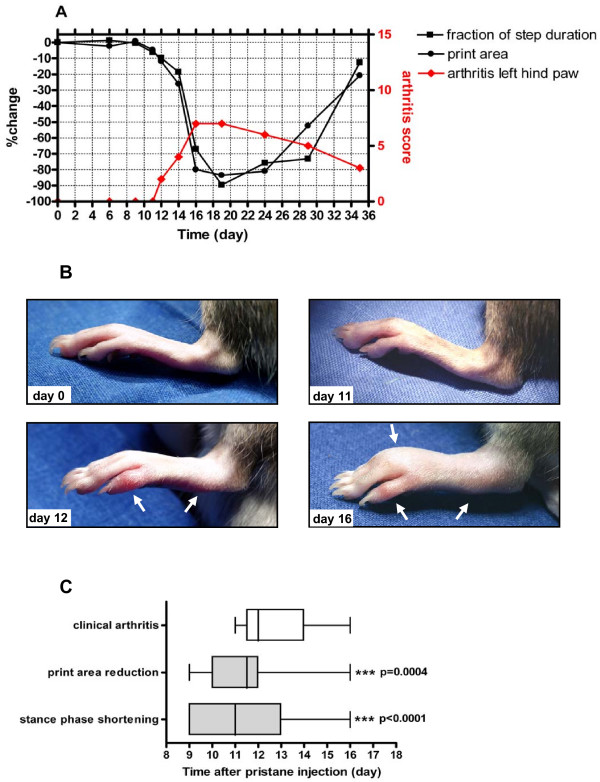
Gait changes occur before visible arthritis is apparent. (A) Time course of the print area and the duration of stance phase measured as the fraction of total step duration of a representative left hind paw after pristane-injection. (B) Photographic images of the left hind paw at characteristic time points (before pristane injection = Day 0, clinically unaffected joint showing gait changes = Day 11, onset of clinical PIA = Day 12, full-blown acute PIA = Day 16). Arrows show location of erythema and swelling on Day 12 and Day 16. (C) Comparison of day of onset of significant gait changes (defined by >5% reduction of print area or shortening of stance phase time versus pre-operative values) versus clinically apparent arthritis in paws with severe arthritis (arthritis score ≥5) reveals that print area reduction and stance phase shortening occur significantly before onset of apparent PIA. Data are presented as box plots. Lines within the boxes represent the median, boxes represent the 25th and 50th percentiles, and lines outside the boxes show the minimum and maximum values.